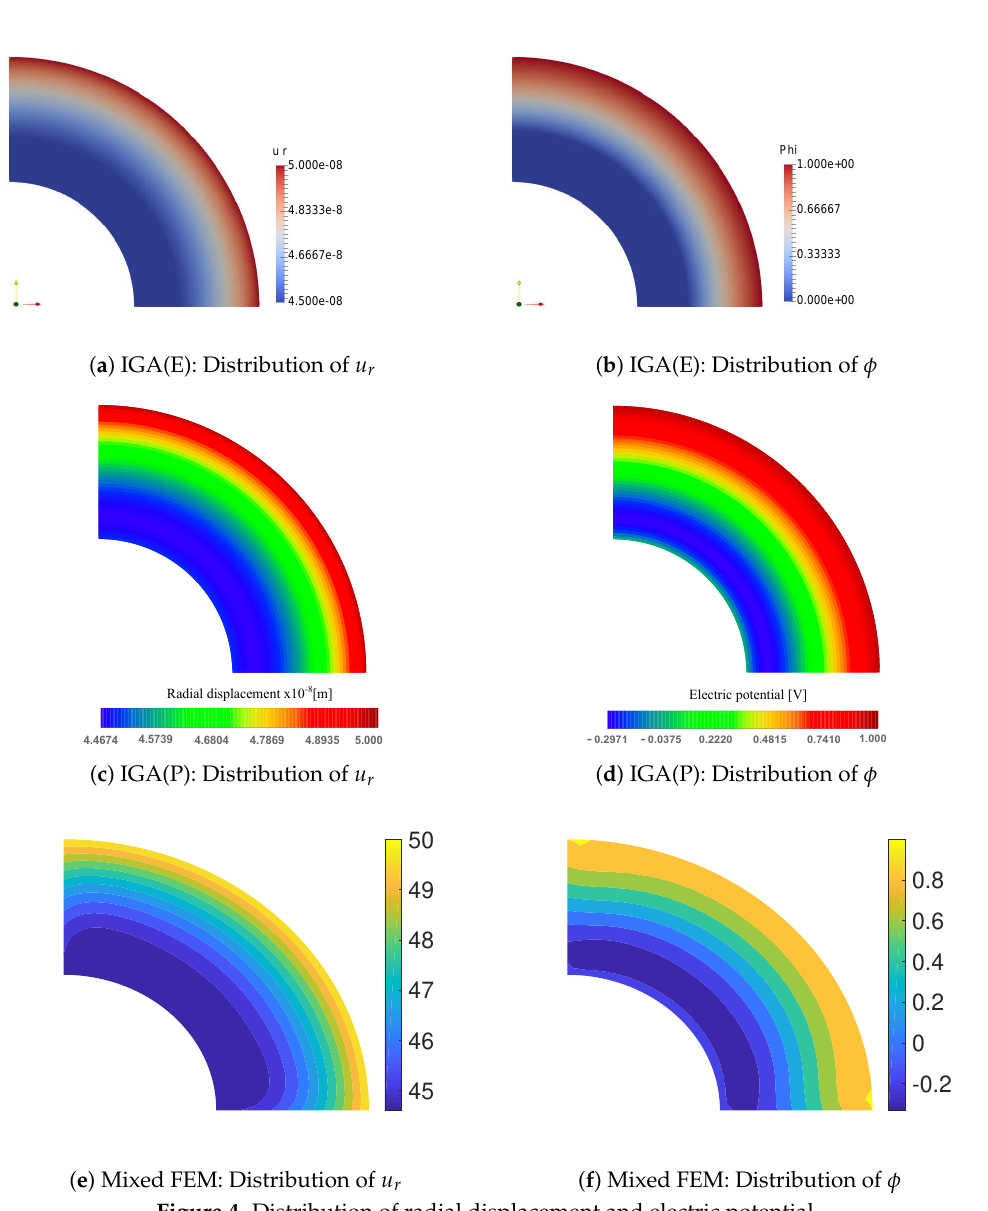
Figure 4. Distribution of radial displacement and electric